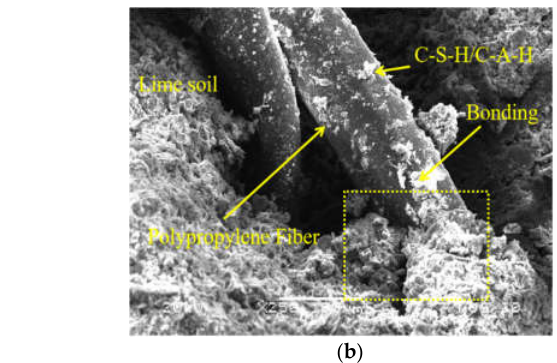
Figure 8. Microcosmic diagram of the interface between PPF and lime-soil: ( a ) 150-fold SEM; ( b ) 250-fold SEM.